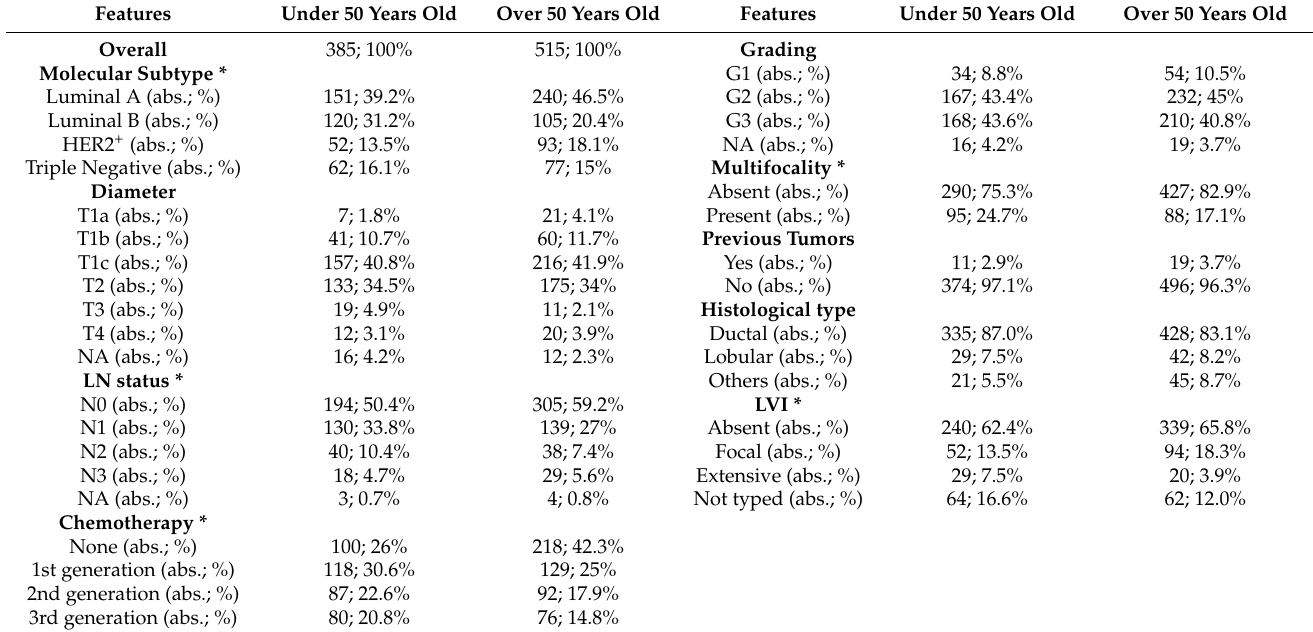
Table 1. Under 50 years old and Over 50 years old sample distributions with respect to the most relevant histopathological features in differentiating breast